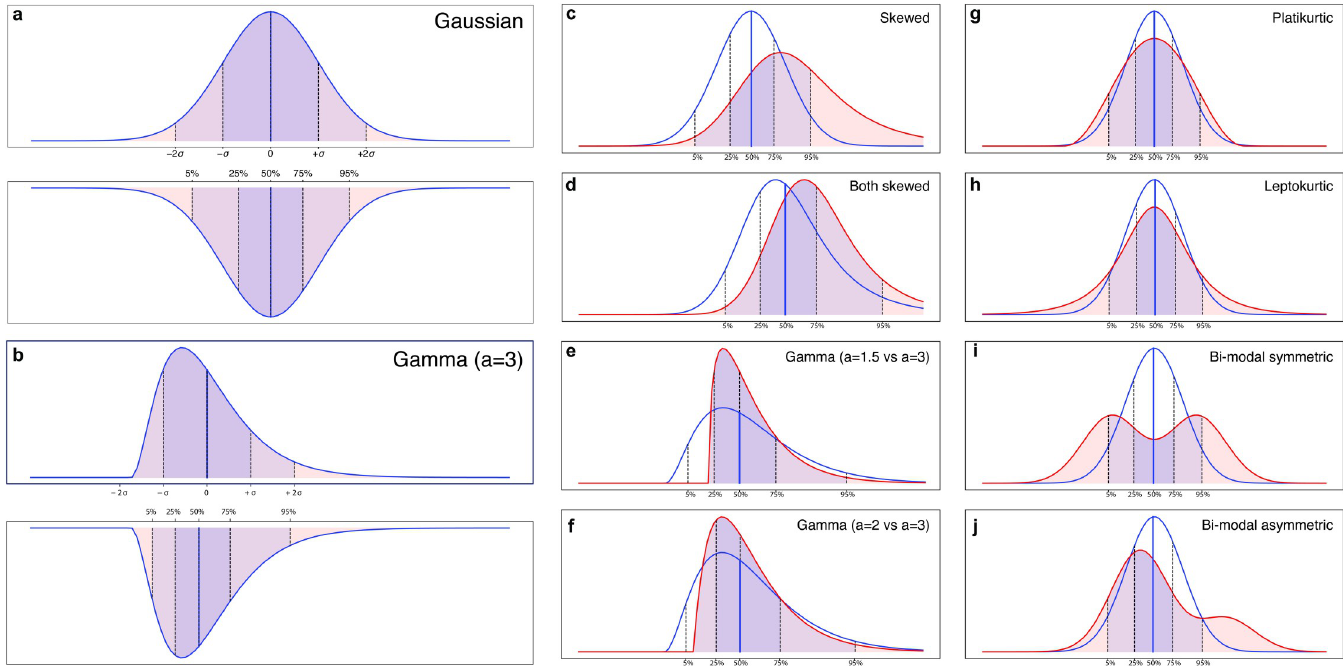
Fig 2. Simulation of how central tendencies and the shape of the distributions impact group overlap. Translating the central tendencies of mean and SD into median and interquartile ranges in (a) normal distribution and (b) skewed distribution. Illustration of group overlap when (c) case group is skewed but control group is normal, (d) both groups are skewed, (e) exponentially modified gamma distribution with strong skewness, and (f) with milder skewness, (g) platykurtosis, (h) leptokurtosis, (i), bimodal equal, (j) bimodal asymmetric. SD, standard